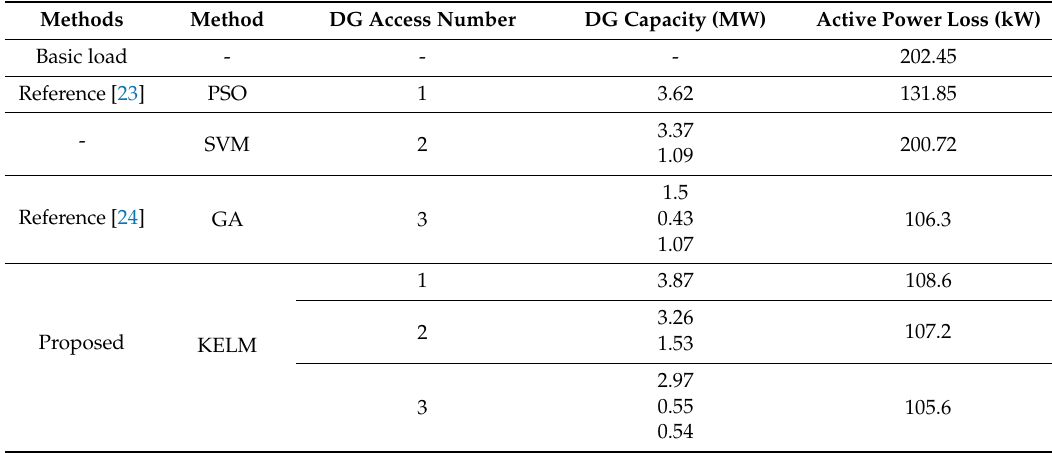
Table 5. Comparison of kernel extreme learning machine with other optimization methods. (PSO: Particle swarm optimization; GA: Genetic